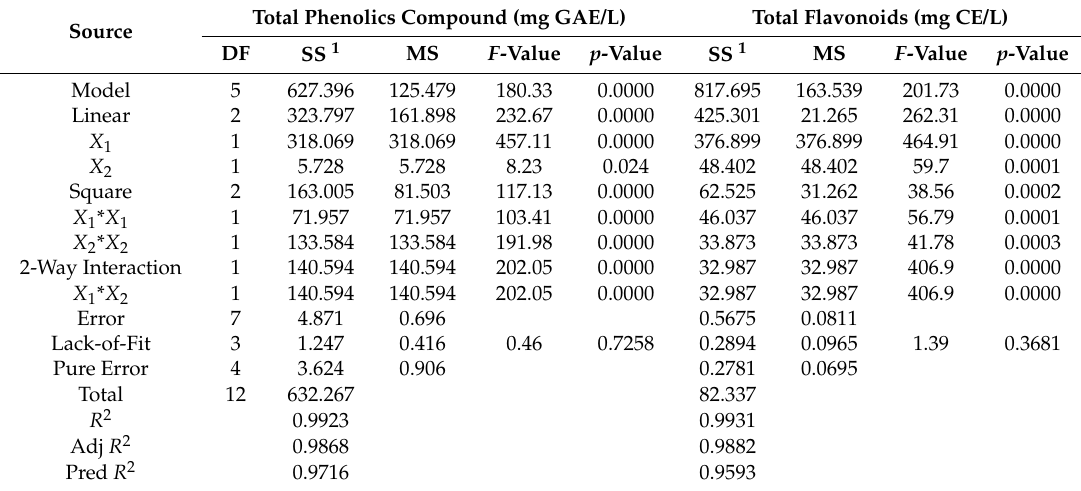
Table 3. Analysis of variance (ANOVA) of responses for total phenolic and total flavonoid